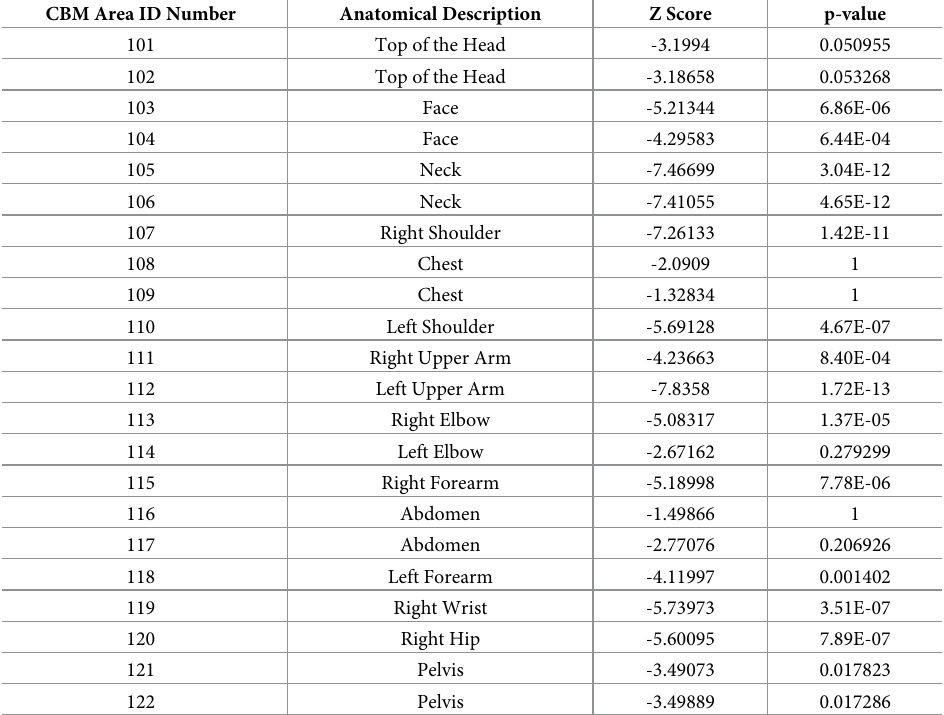
Fig 4. The distribution of the number of areas on the CBM (each bar represents one value) that each patient endorses can be visualized with the plot_nareas_histogram() function. https://doi.org/10.1371/journal.pcbi.1010496.g004 Table 1. The results of a left-tailed z-test to determine whether the proportion of men endorsing each body map area was less than the proportion of women endorsing the same area. The p-values were adjusted for multiple hypothesis testing with the Bonferroni correction (the default for the package function comp_choirbm_ztest()). Loca- tion codes that start with a “1” indicate the front of the body and codes that begin with a “2” indicate the back of the